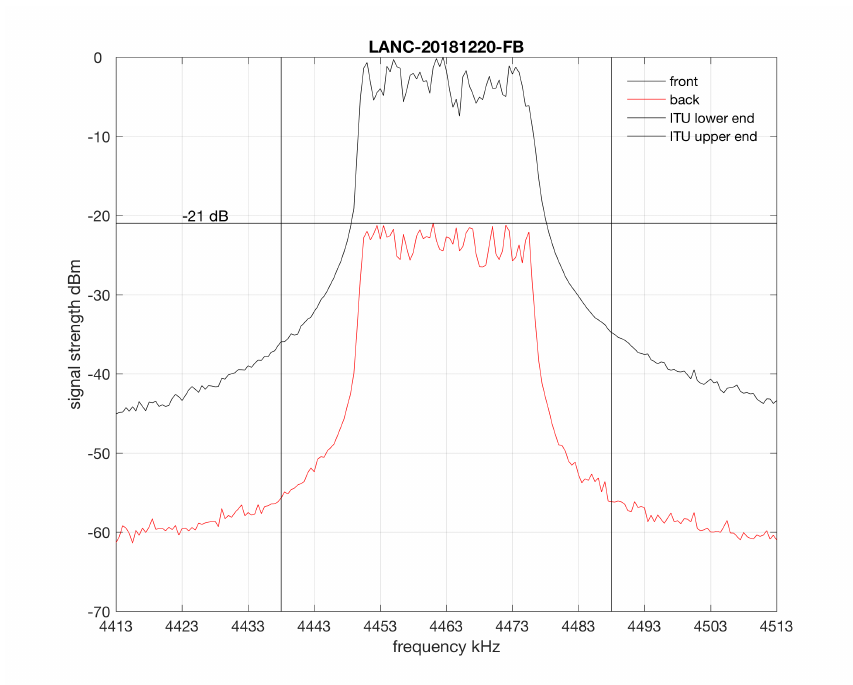
Figure 8. FieldFox scan data collected at the front and back of the prototype directive antenna in the field tests at Lancelin SeaSonde system. The red (black) curve corresponds to data collected at the expected back (front) lobes. The upper and lower limits of the 4 MHz ITU band allocated to HFR operations are also marked. Spectra scans are normalised by the maximum amplitude of the FieldFox scan at the front location. Difference between the maximum amplitudes of the two curves is 21